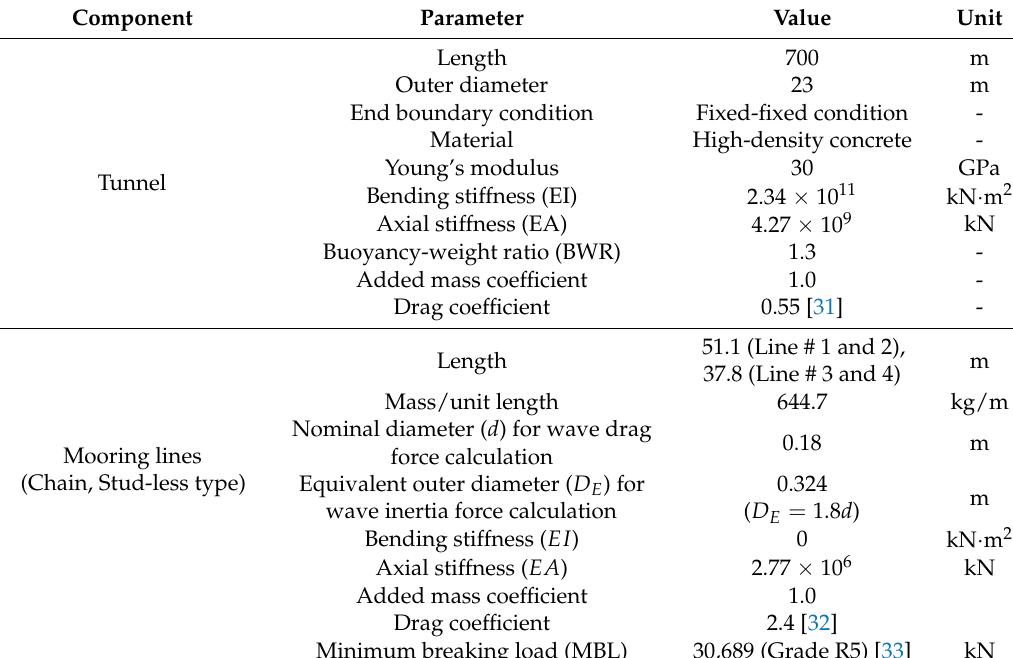
Figure 1. 2D and 3D views of the entire structure. Table 1. Major parameters of the tunnel and mooring lines.